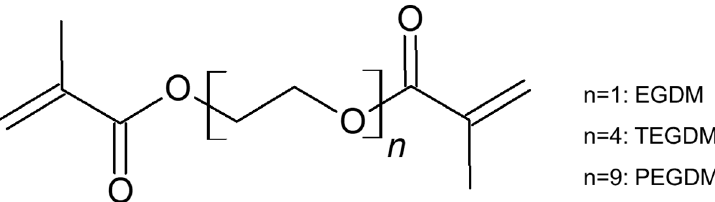
Figure 2. Structure of crosslinkers.